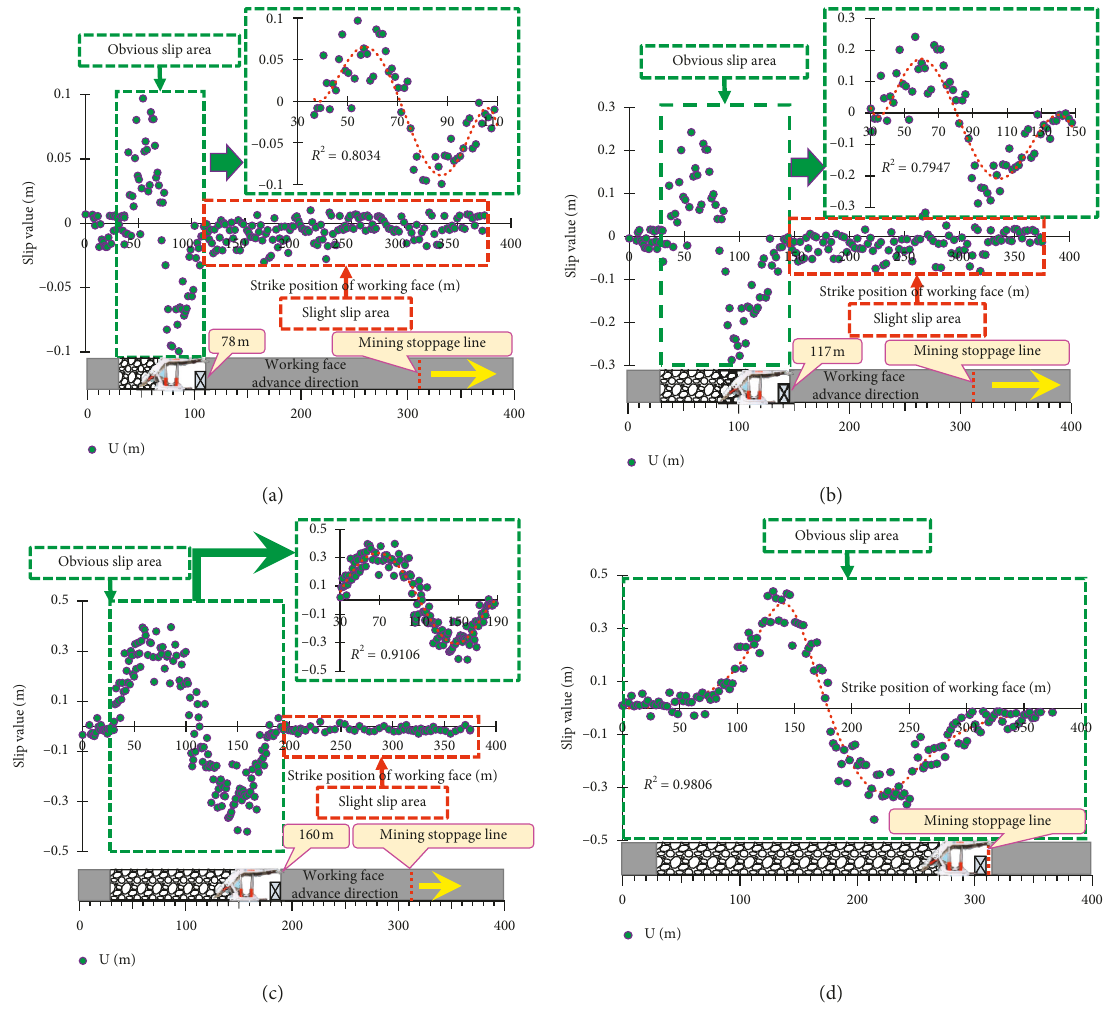
Figure 13: Horizontal slip curves in the working face of different advance distances. (a) 78m, (b) 117m, (c) 160m, and (d) 315